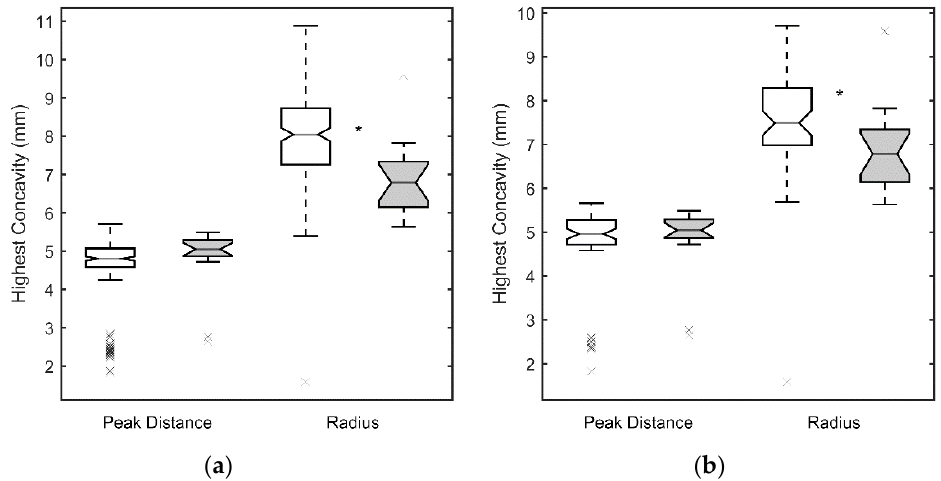
Figure 4. Peak Distance (PD) and radius at highest concavity (R HC ) for the SCKC (grey) and control groups (white). Symbols as in Figure 1. ( a ) whole control group, ( b ) IOP and CCT matched control group.